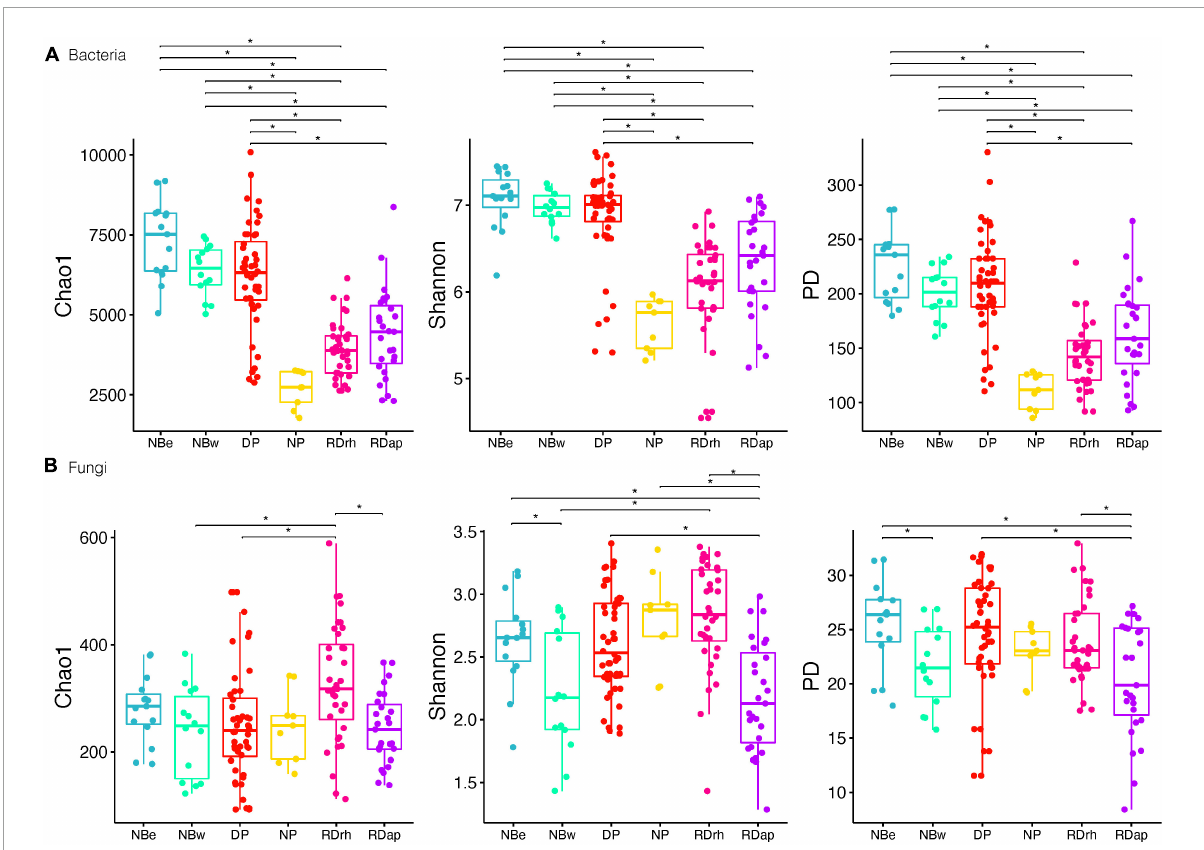
FIGURE3 Bacteria (A) and fungi (B) alpha diversity (Chao1; Shannon; phylogenetic diversity) for sampling sites North Beach East [NBe], North Beach West [NBw], Devil’s Point [DP], Nikopol Point [NP], Rotch Dome Ritli Hill [RDrh], and Rotch Dome Amadok Point [RDap]. Dots represent data points, and boxplots represent the interquartile range of alpha diversity. Statistically significant differences (Tukey’s HSD p -value ≤ 0.05, for predicted alpha diversity by a linear model) are marked by